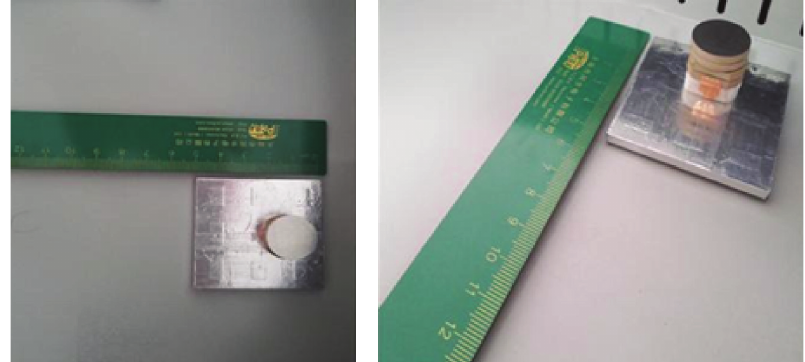
Figure 9: Photograph of the manufactured DRA.